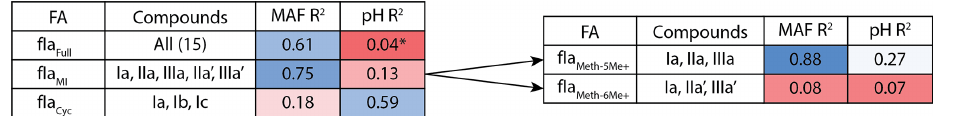
Figure 3. Adjusted R 2 values for a linear regression of environmental parameters against the fractional abundance (FA) of brGDGT-Ia calculated within different structural sets. Colors denote the strengths of the relationships, from the minimum to the maximum observed coefficients of determination, with white being the median of the dataset. “Compounds” denote all brGDGTs used in the FA calculation. All values are significant ( p < 0.01) unless marked with an asterisk.